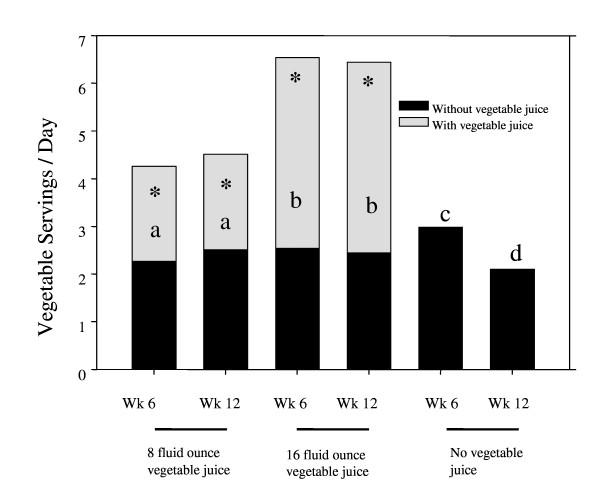
Comparison of vegetable intake (servings per day) among vegetable juice consumption groups at weeks 6 and 12. * a Significantly different from no vegetable juice c at 6 weeks and d at 12 weeks p ≤ 0.01, b significantly different from 8 fluid ounces and no vegetable juice groups at 6 weeks, and at 12 weeks p ≤ 0.0001. Vegetable consumption in the week 12 no vegetable juice group was significantly decreased from week 6 p ≤ 0.01. 8 fluid ounce group n = 26; 16 fluid ounce group n = 27; no vegetable juice n = 27.